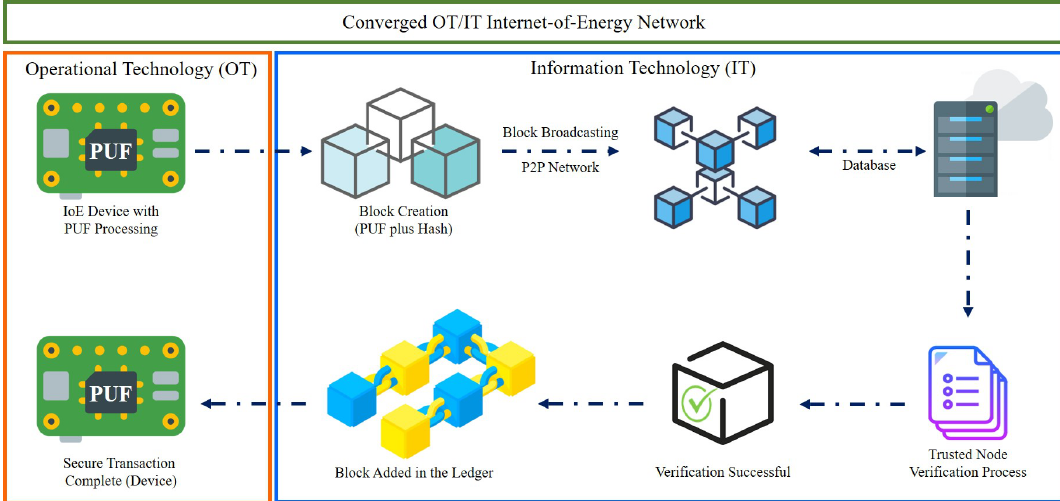
Figure 9. Networking architecture of